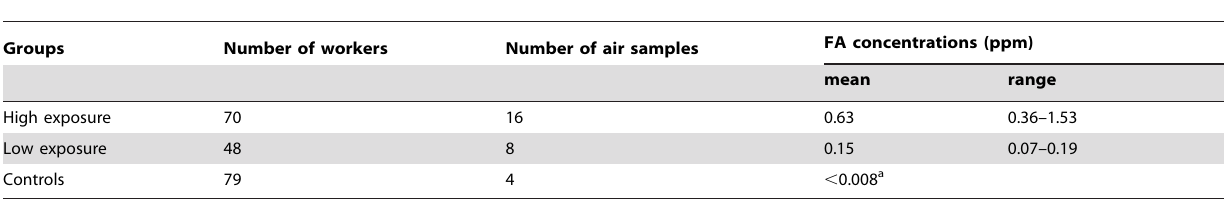
Table 1. The FA exposure levels in FA-exposed workers and